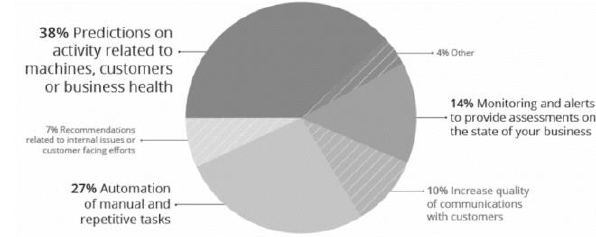
Figure 4. Outlook on AI-Powered solutions